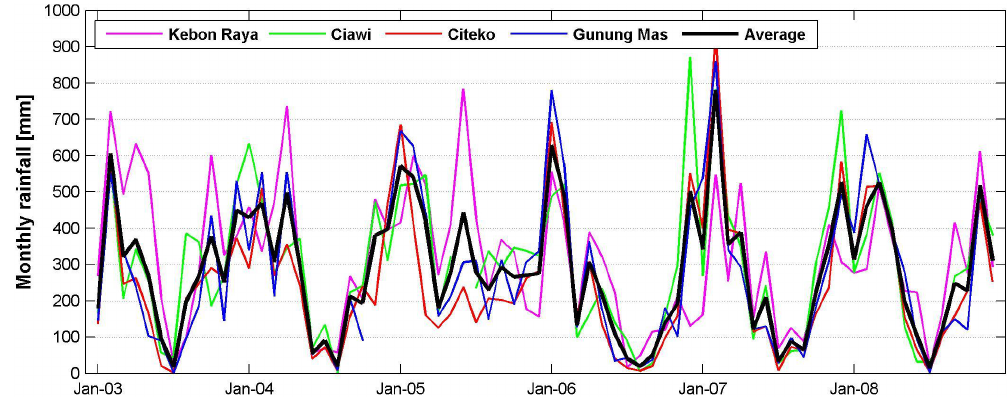
Fig. 2. Monthly ground station rainfall records for the period 2003–2008 in a single satellite grid cell, around Bogor.